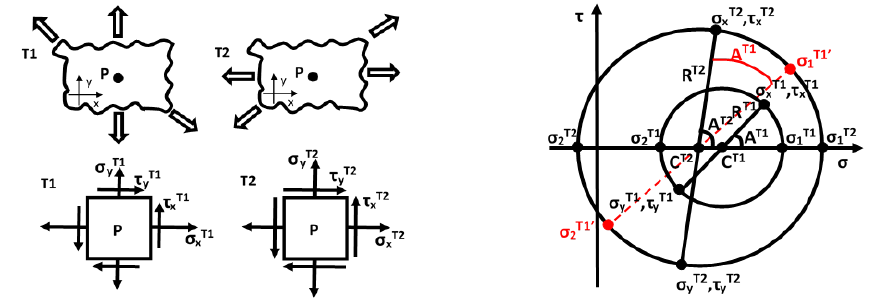
Figure 3. Material response states at different time instants.